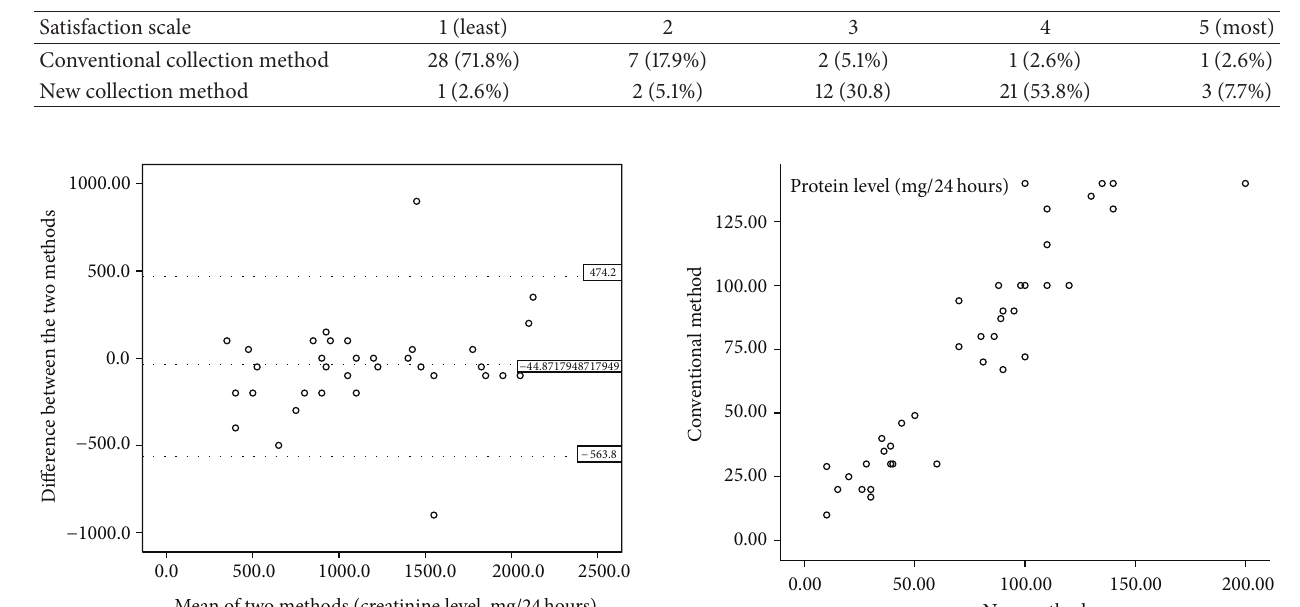
Table 1: Satisfaction of patients with each 24-hour collection method.